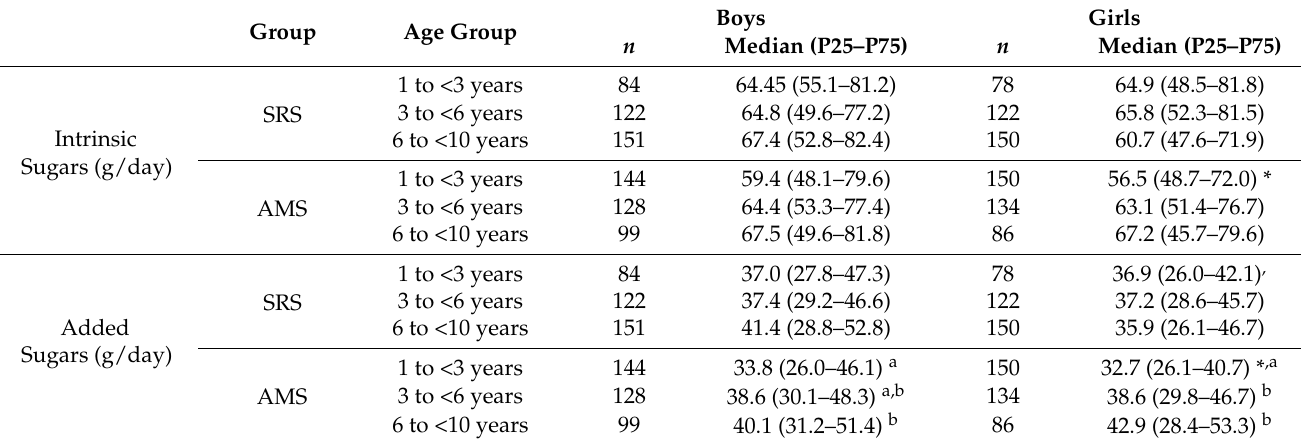
Table 1. Usual intrinsic and added sugar intakes by gender and age group in the Spanish Pediatric Population (EsNuPI)